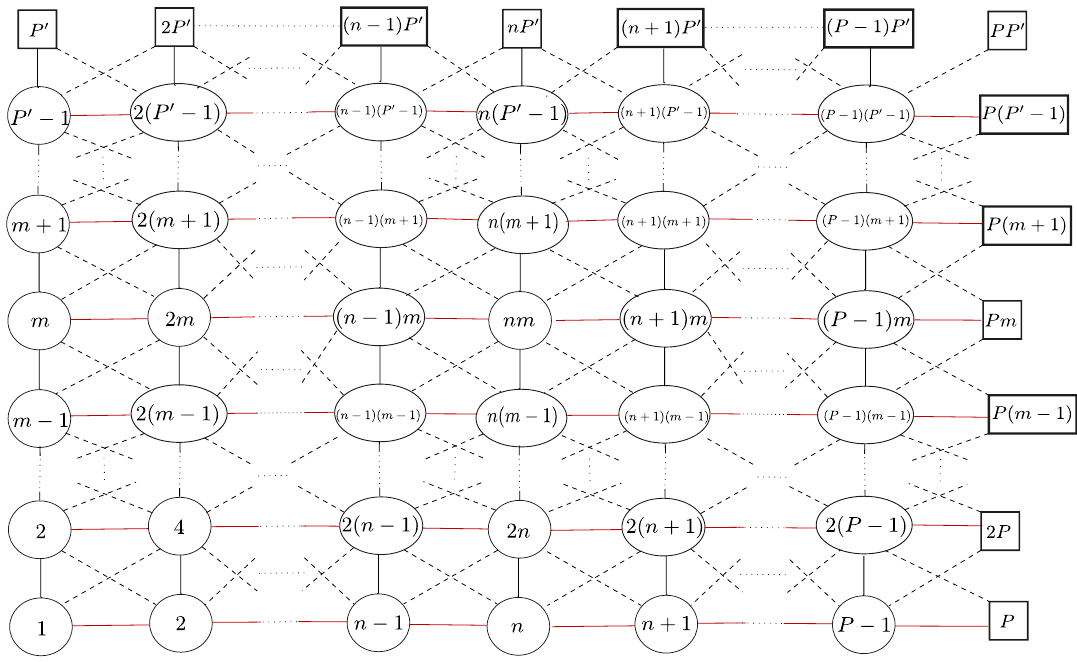
Figure 4 . Quiver quantum mechanics associated to the AdS 2 solution given by (2.8). Circles denote (0,4) vector multiplets, red lines (0,4) bifundamental twisted hypermultiplets, black lines (0,4) bifundamental hypermultiplets and dashed lines bifundamental (0,2) Fermi multiplets. We have taken units in which Q = 1 . D 6 Figure 5 . Field theory living in the D4-NS5-D6 subsystem (in units of Q D 6 = 1 ) in terms of 2d (0,4)